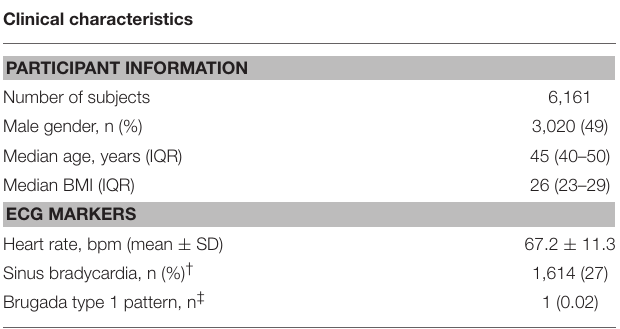
TABLE 1 | Baseline characteristics of the study